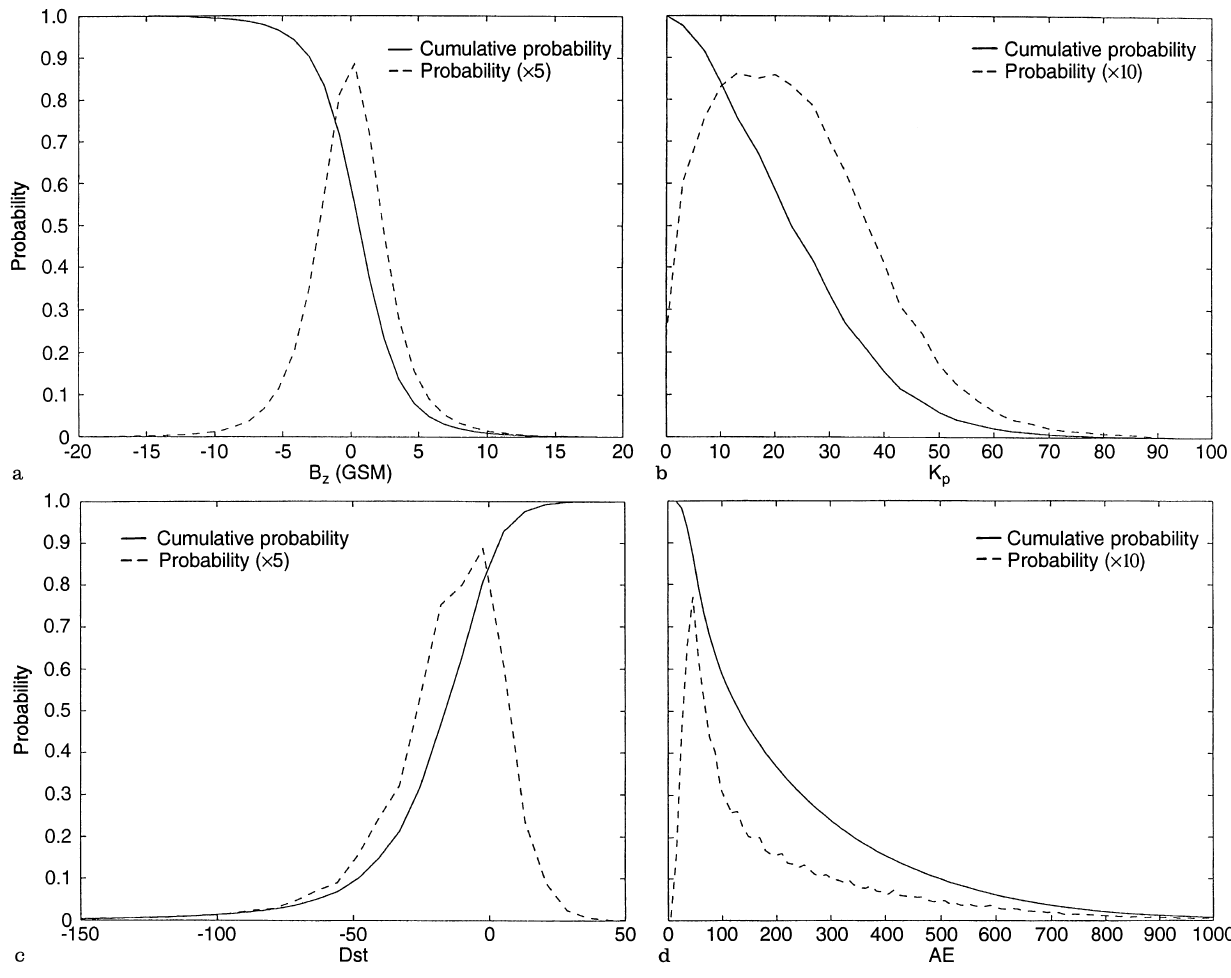
Fig. 6a–d. As for Fig. 2 for a B z , b K p , c Dst and d